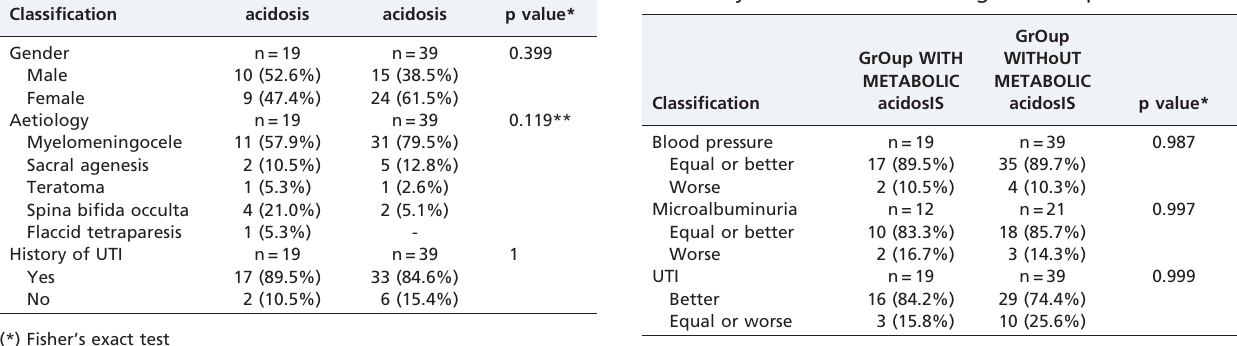
Table 7 - Comparison between the group without metabolic acidosis and the group with metabolic acidosis regarding blood pressure, microalbuminuria and number of urinary tract infections during follow